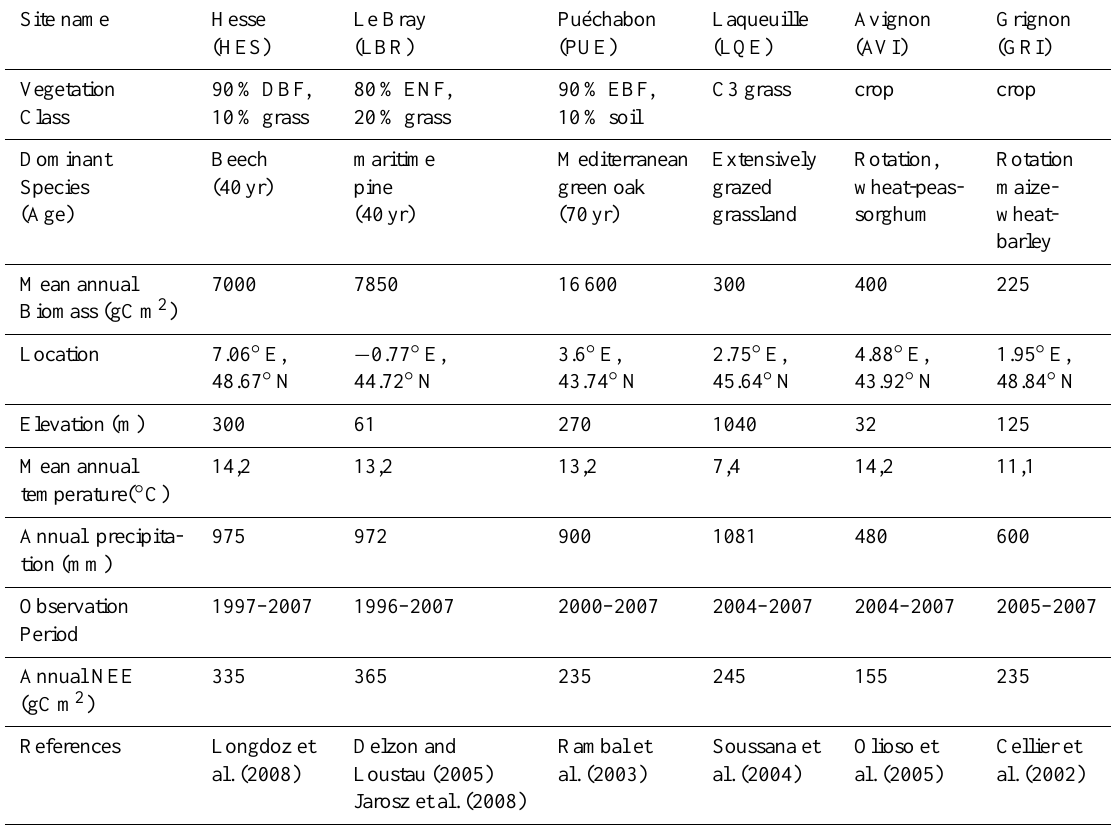
Table 1. Summary of eddy flux observation sites used in this